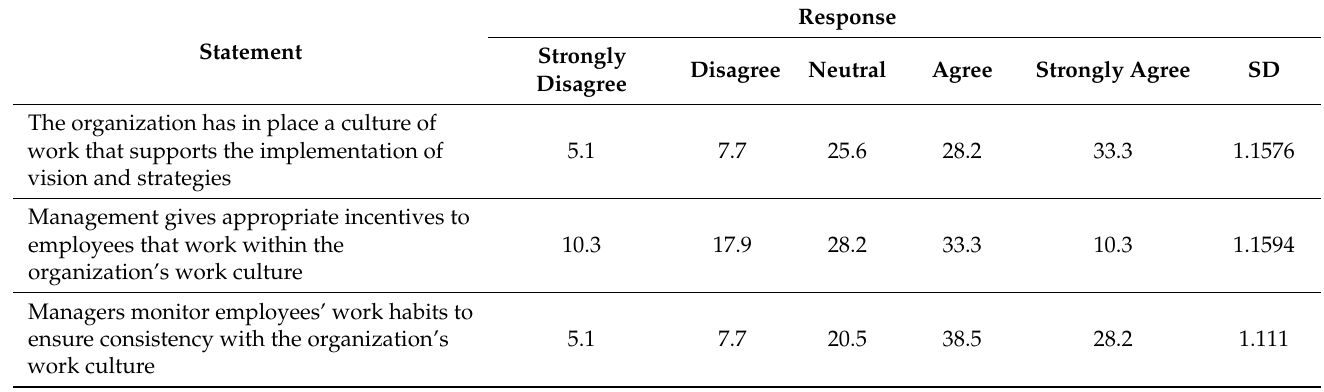
Table 3. Descriptive statistics for organizational culture change and performance at the refreezing